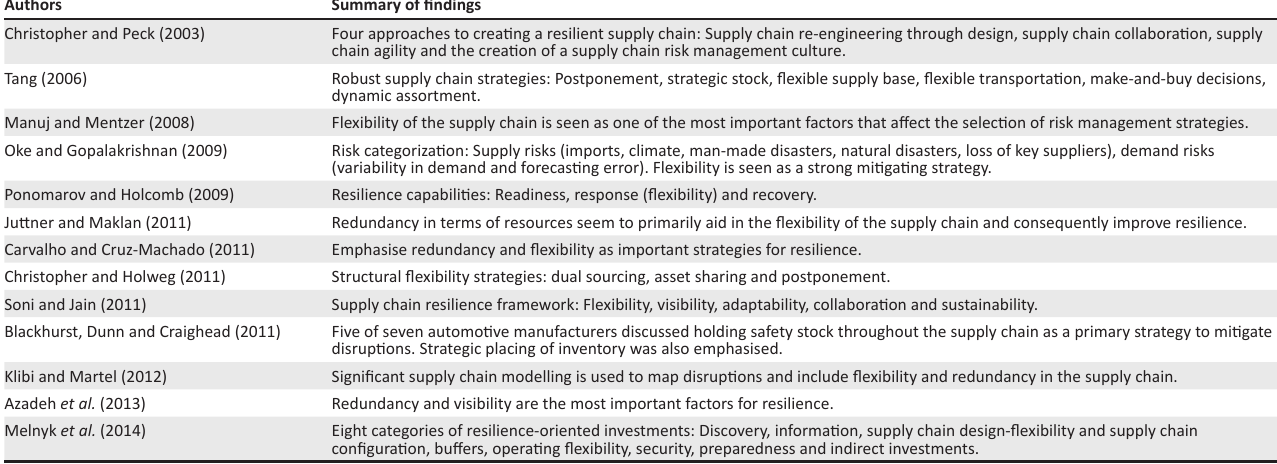
TABLE 1: Review of the literature on supply chain design strategies for supply chain resilience.